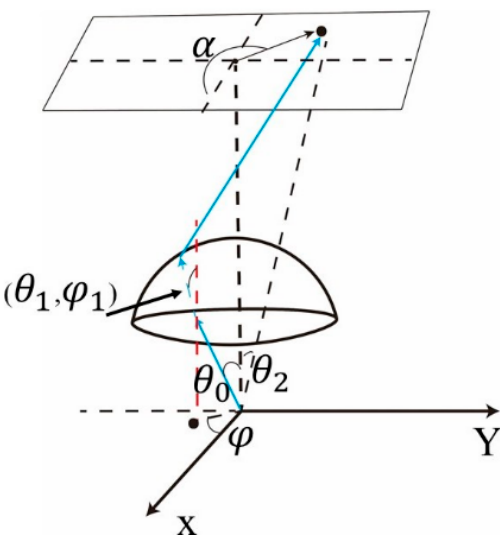
Double freeform surface lens (DFSL) has many advantages over single freeform surface lens. For example, it can achieve an accurate distribution of light and suppress chromatic dispersion by its inner and outer freeform surfaces [15]. The deflection factor C (0 ≤ C ≤ 1), an important factor in DFSL, is used to represent the angular deflection ratio of two freeform surfaces. It is worth noting that θ , ϕ are zenith angle and azimuth angle, respectively, and α is the angle between the discrete points on the target plane and positive X axis (Figure 4). The ray’s angle after passing through the inner freeform surface could be denoted as follows: